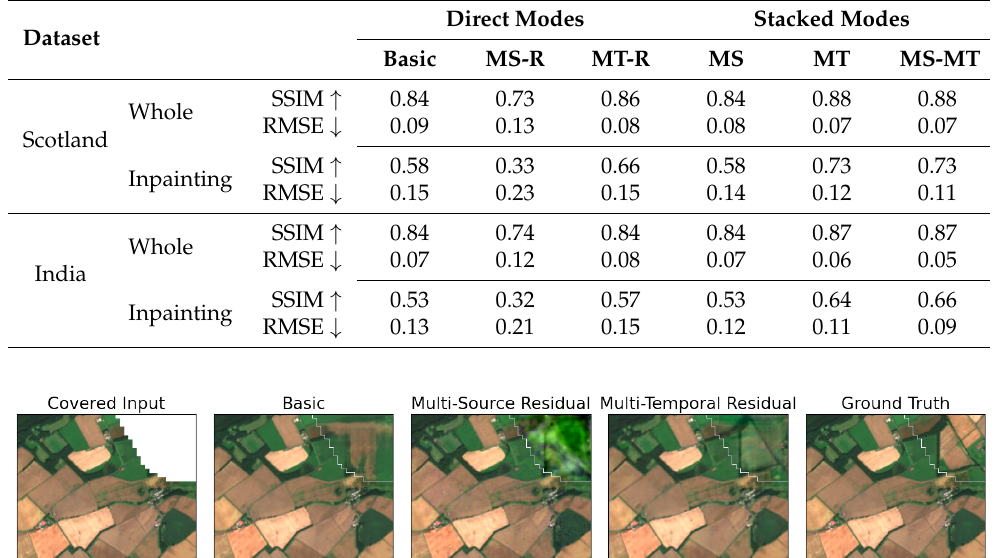
Table 2. MS—Multi-Source (Sentinel 1), MT—Multi-Temporal, -R—Residual Variants. Optimal performance maximizes SSIM and minimizes RMSE. This occurs for the modes using temporal support data, with the MS-MT mode surpassing all other for both dataset and both for the inpainting region and the whole image.